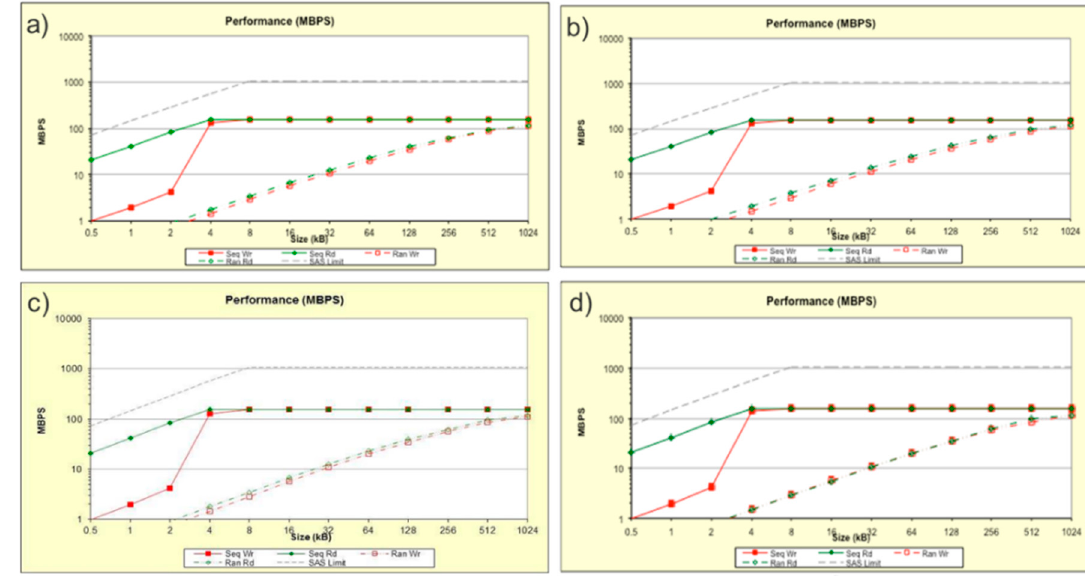
Figure 19. Optically enabled data storage system performance in terms of error-free data transfers per data block size with different waveguides connected to the system. ( a ) reference measurement with fiber only system, ( b ) Keio mosquito waveguide channel 5 operating at 850 nm, ( c ) Sumitomo Bakelite waveguide channel 1 operating at 850 nm, ( d ) IZM glass waveguide set 7 channel 12 at 850 nm.